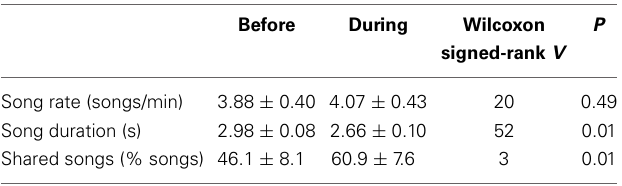
Table 3 | Male singing behavior before and during bouts of concurrent song with